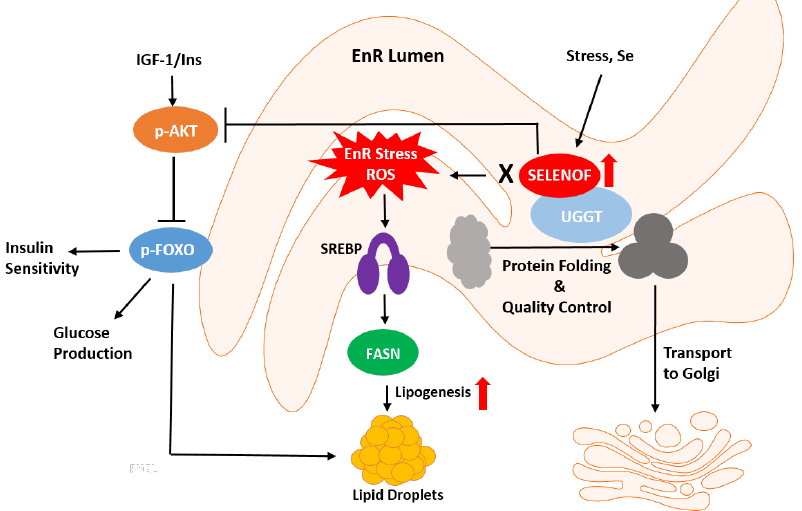
Figure 1. Schematic representation of SELENOF’s putative roles in redox protein quality control and metabolism. SELENOF in most tissues, except for normal prostate, resides in the endoplasmic reticulum (EnR). SELENOF associates with UGGT (UDP-glucose:glycoprotein glucosyltransferase) and regulates protein disulfide bond formation and redox quality control. SELENOF-dependent disruption of EnR homeostasis possibly through ROS (reactive oxygen species) leads to metabolic dysregulation, such as insulin insensitivity or glucose production via AKT (protein kinase B) and FOXO, (forkhead box O, a transcription factor), or lipogenesis via SREBP (sterol regulatory element binding protein, a transcription factor) and FASN (fatty acid